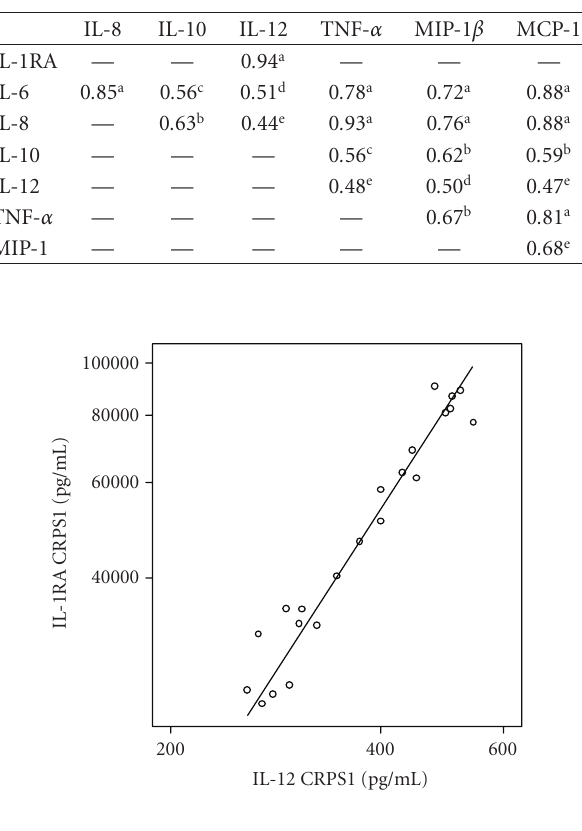
Figure 2: Example of a regression curve between concentrations of IL-1RA and IL-12 in 22 blister fluid samples taken from the CRPS1 extremity (correlation coe ffi cient 0 . 97, P < . 001), measured by the multiplex-25 bead array assay. Values are calculated in pg/mL and plotted on a logarithmic